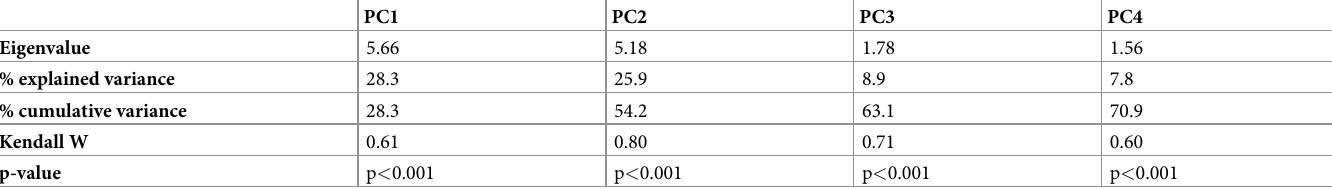
Table 5. Principal component (PC) analysis outcomes and inter-observer agreement (using Kendall’s W) for QBA rating scales.